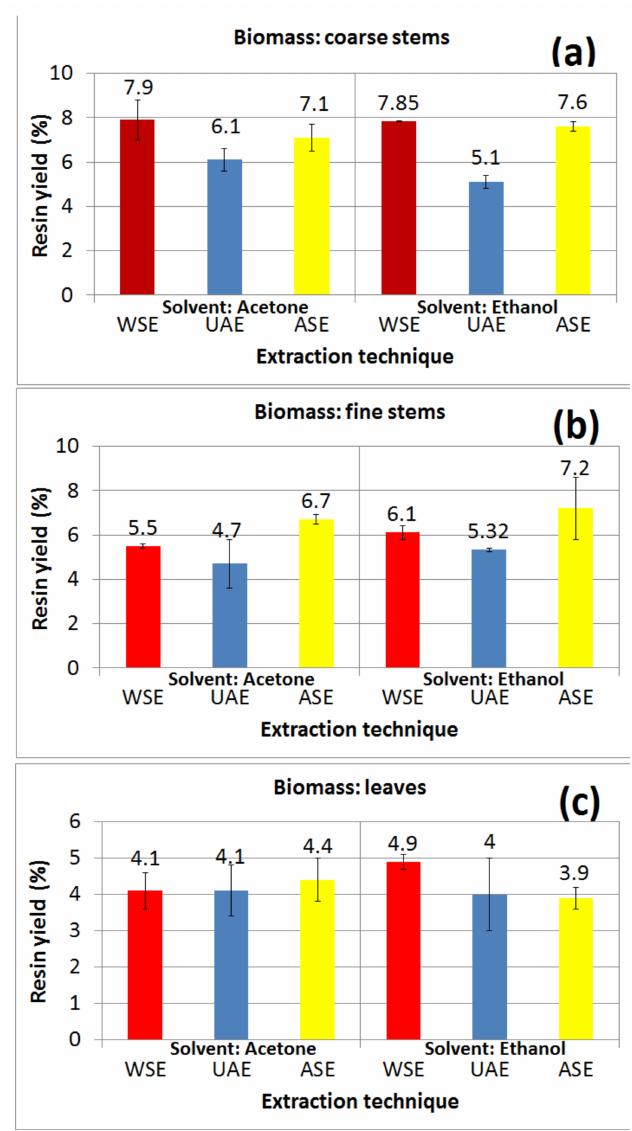
Figure 1. Comparison of average solvent extraction yields in resin (% on the biomass amount), n = 3. Solvents: acetone or ethanol. ( a ) biomass: coarse stems; ( b ) biomass: fine stems; ( c ) biomass: leaves. WSE: warm solvent extraction; UAE: ultrasonic-assisted extraction; ASE: accelerated solvent